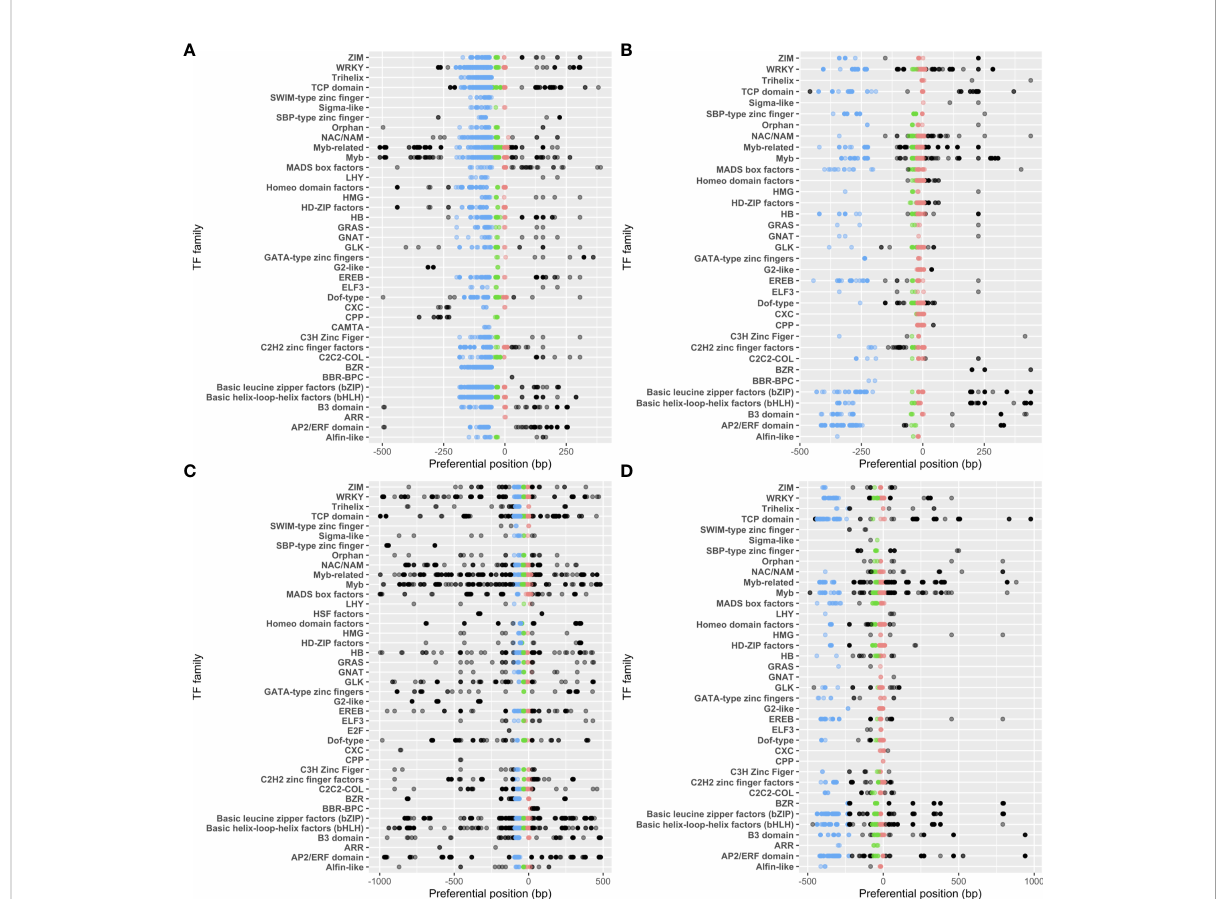
FIGURE 4 tPLM preferential positions per TF family. tPLMs in 5 ’ - (A) and 3 ’ - (B) gene-proximal regions of A. thaliana . tPLMs in 5 ’ - (C) and 3 ’ - (D) gene proximal regions of Z. mays . Blue, green and red points correspond to the tPLMs in groups 1, 2 and 3, respectively. The black points correspond the tPLMs that do not belong to any group. The opacity of the points is relative to the number of tPLMs at that